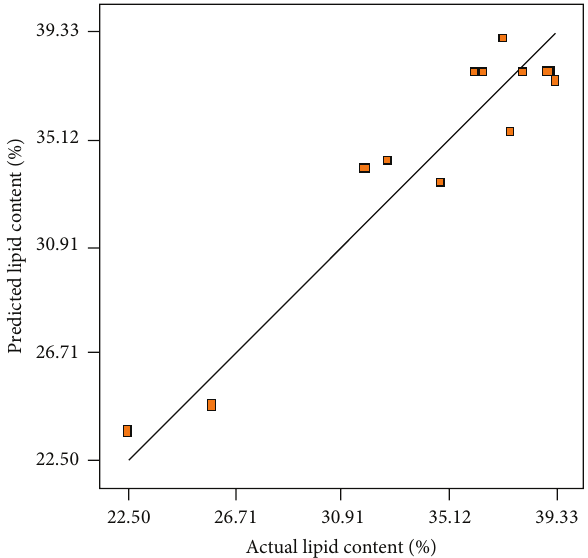
Figure 6: Response surface plot showing the simultaneous effects of aeration rate and agitation rate on lipid content produced by Cunninghamella bainieri 2A1.